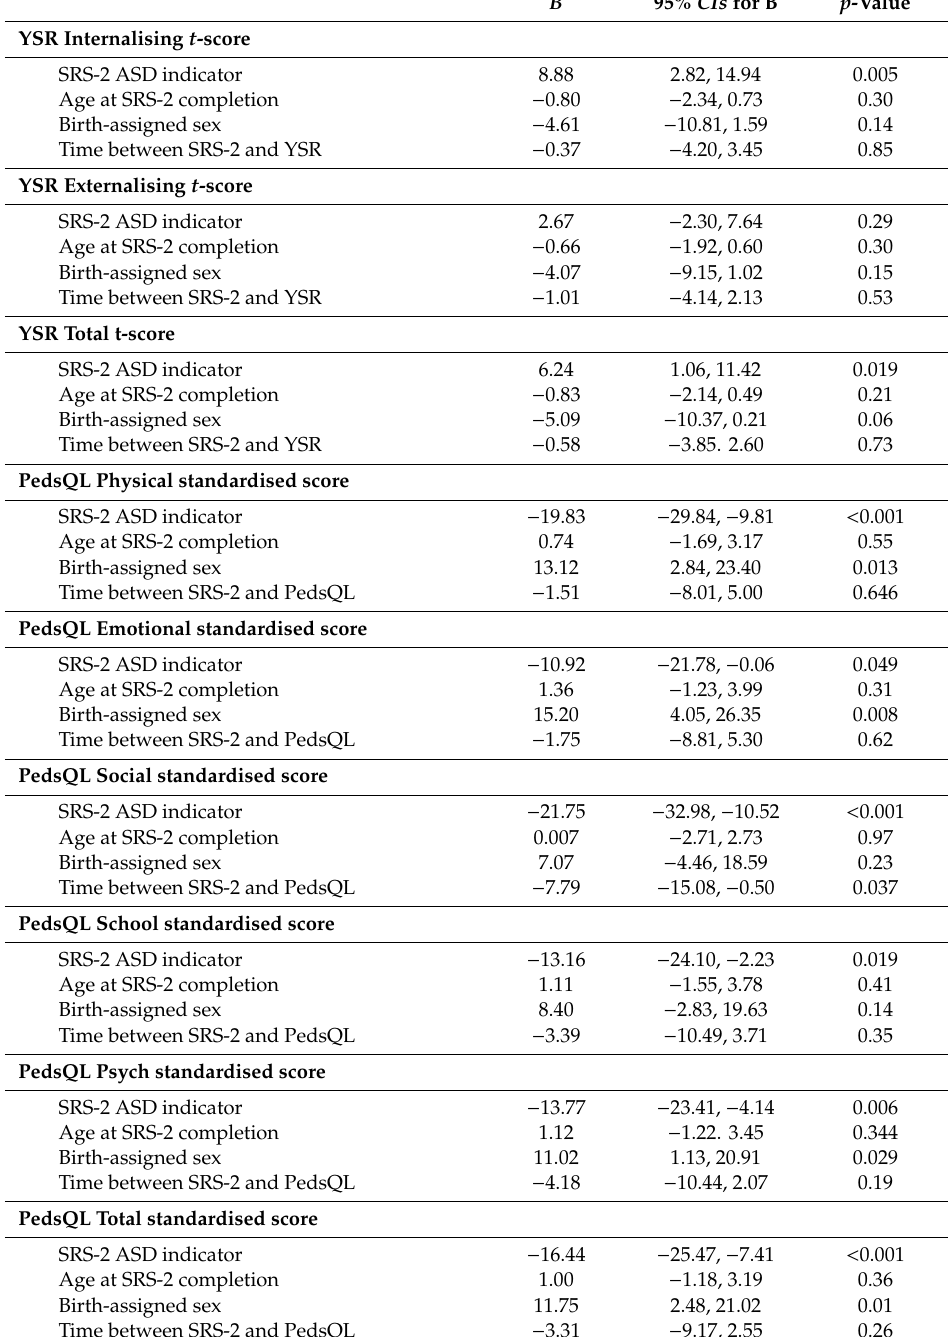
Table 4. Indicated and no indicated ASD on the SRS-2 DSM-5 subscale predicting psychopathology and quality of